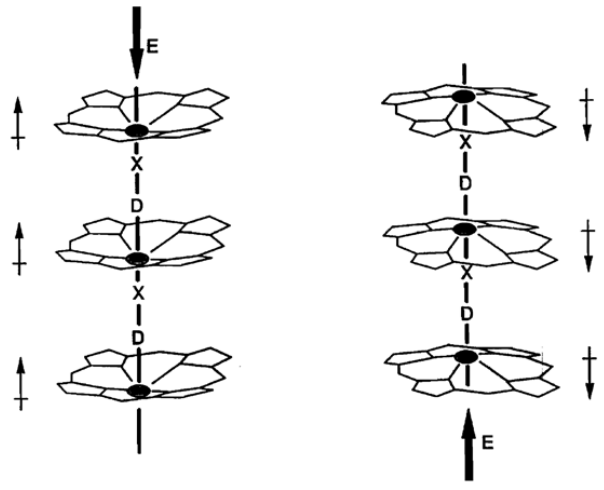
Figure 16. Schematic representation of dipole moment switching in a ferroelectric porphyrin polymer. D = donor, X = acceptor. After Ref. [48], with permission from Elsevier.